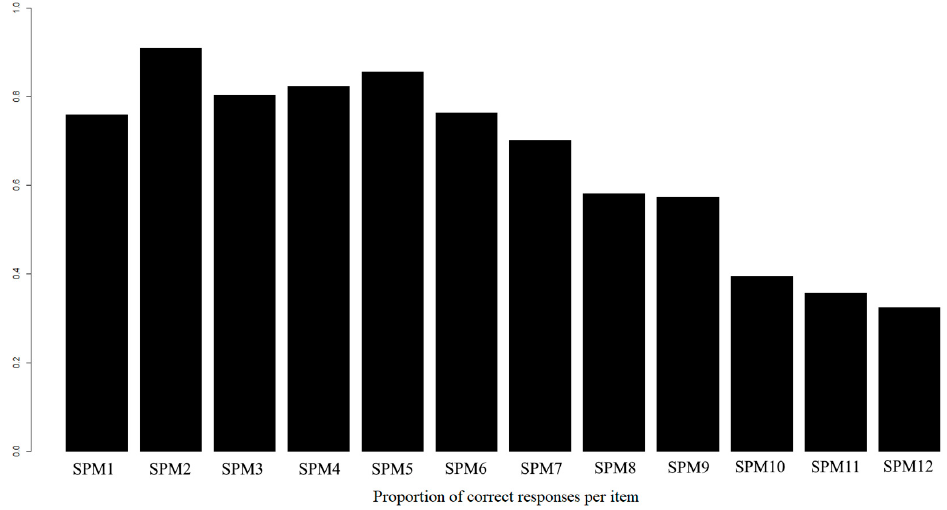
Figure 2. Proportion of correct responses as a function of item location in the SPM-LS.